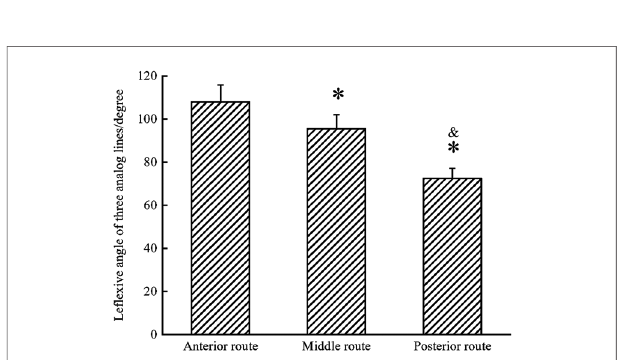
FIGURE 5 | Statistical chart of the CC7 nerve included angles of three prespinal routes. *The included angles of the two were signi fi cantly smaller than that of the anterior route (the middle, p <0.001; the posterior, p < 0.001). & The included angle of the middle route was larger than that of the posterior route ( p <0.001).